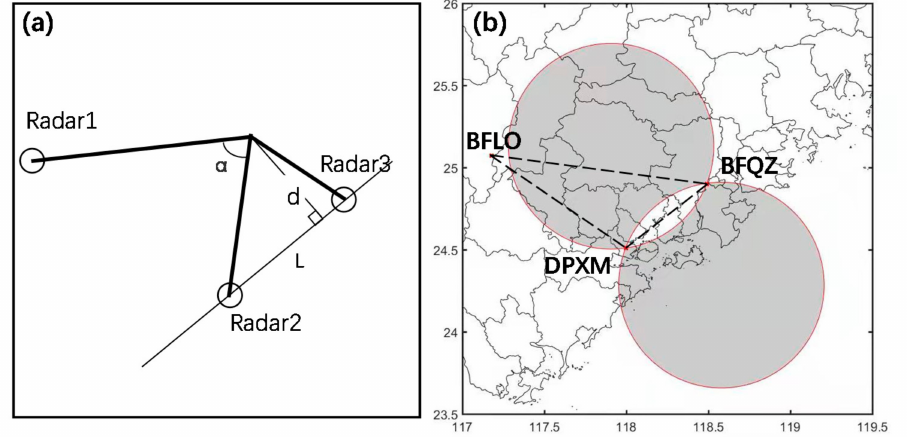
Figure A1. ( a ) Diagram of influencing factors for the dual-radar retrievals error. ( b ) The baseline of the three radars (black dashed line) and the optimal retrieved areas of DPXM and BFQZ (gray